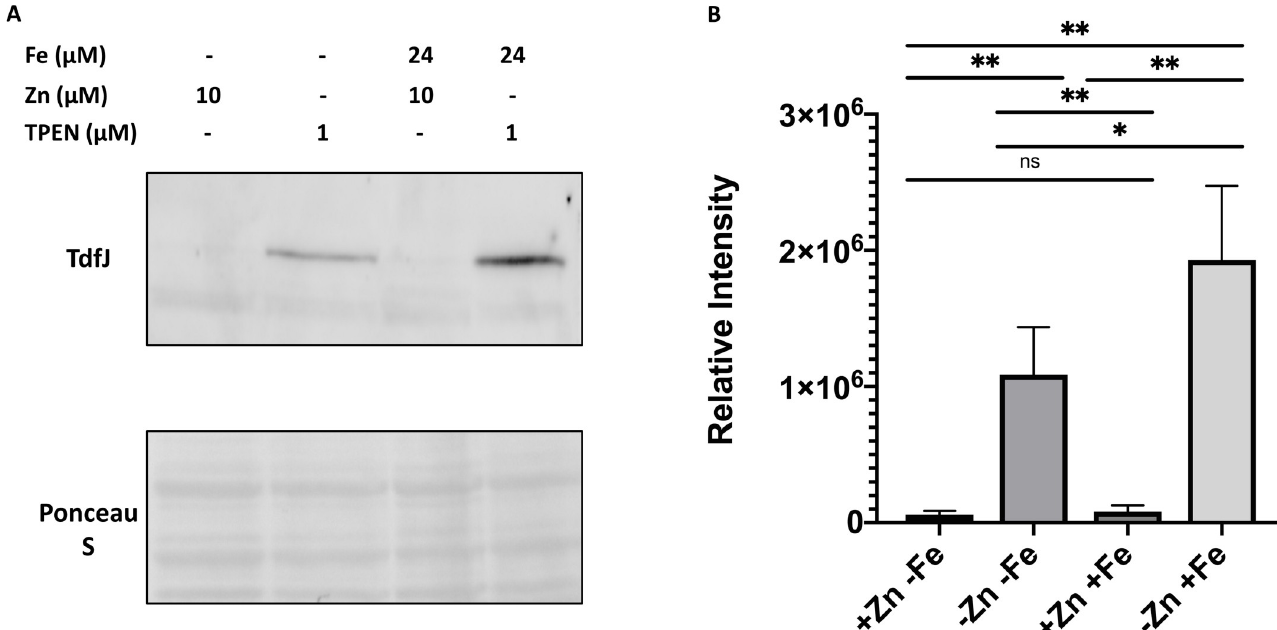
Fig 3. TdfJ is zinc repressed and iron induced. (A) Strain FA19 was grown in CDM until exponential growth, then back diluted in the same media and treated with Fe(NO 3 ) 3 , ZnSO 4 , and/or TPEN in the concentrations indicated. These cultures were grown for 6 hours before whole-cell lysates of equalized density were prepared and subjected to SDS-PAGE and subsequent immunoblotting with antiserum raised against TdfJ. The Ponceau stained blot shows equal protein loading. Blot is representative of N = 4 experiments. (B) Western blots shown in panel (A) were analyzed for signal intensity using BioRad Image Lab software. Statistical significance was determined using an unpaired Welch’s t-test. � , P � . 05; �� , P � .005; ��� , P � .0005; ���� , P � .0001.